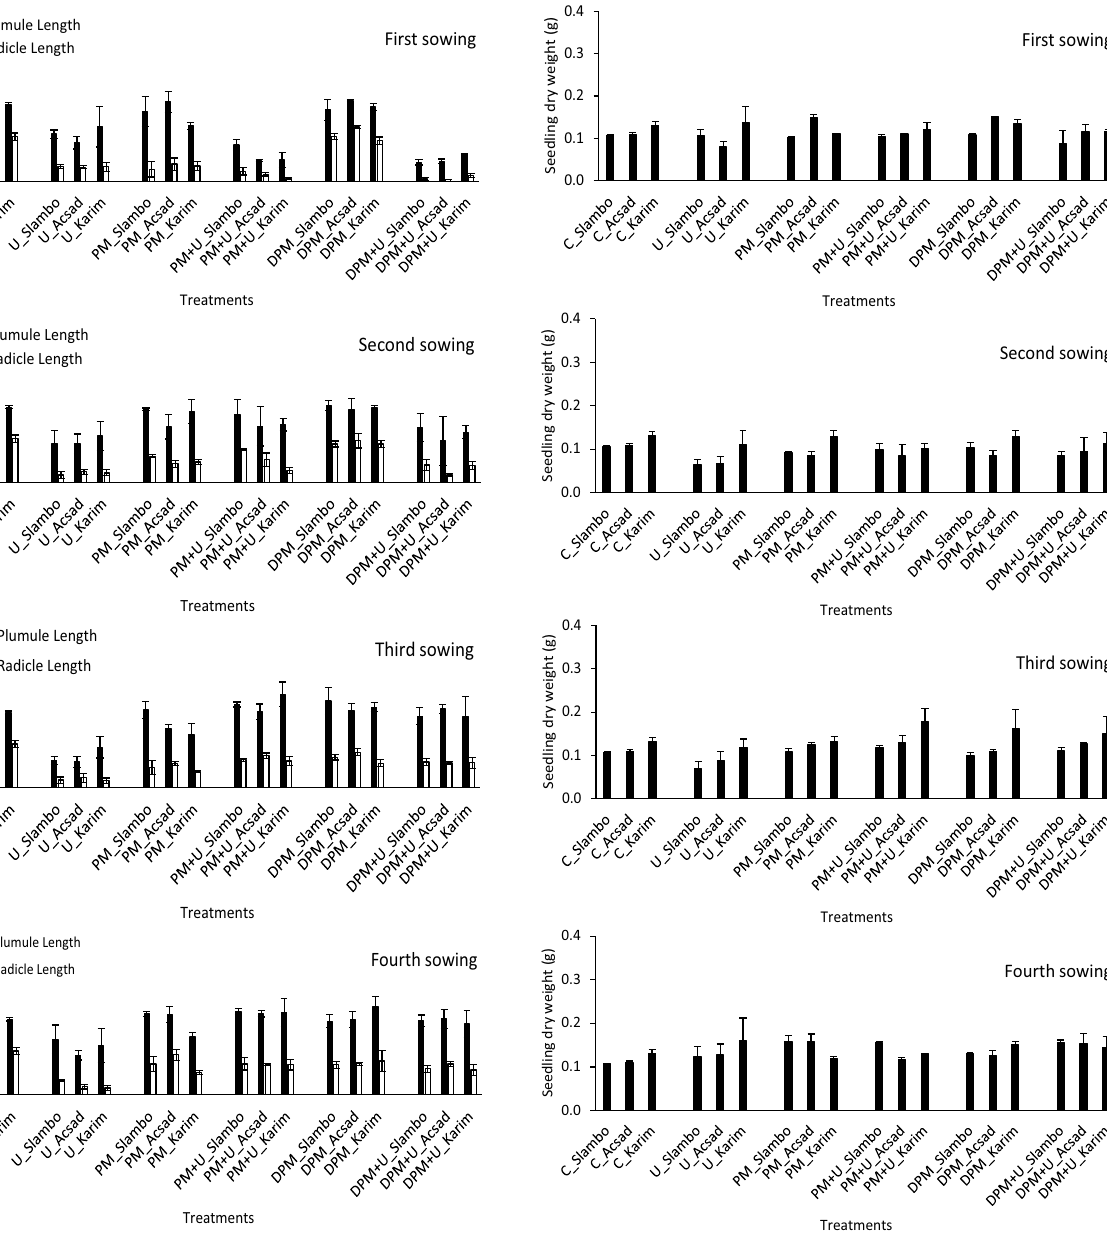
Fig. 1 Plumule and radicle length of three wheat cultivars ( Slambo , Acsad and Karim ) after 14 days growing period sown in desert soil on four sowing dates after amendment with non-digested and anaero- bically digested poultry manure with and without combination with urea. Bars represent mean ± standard deviation ( n = 4)